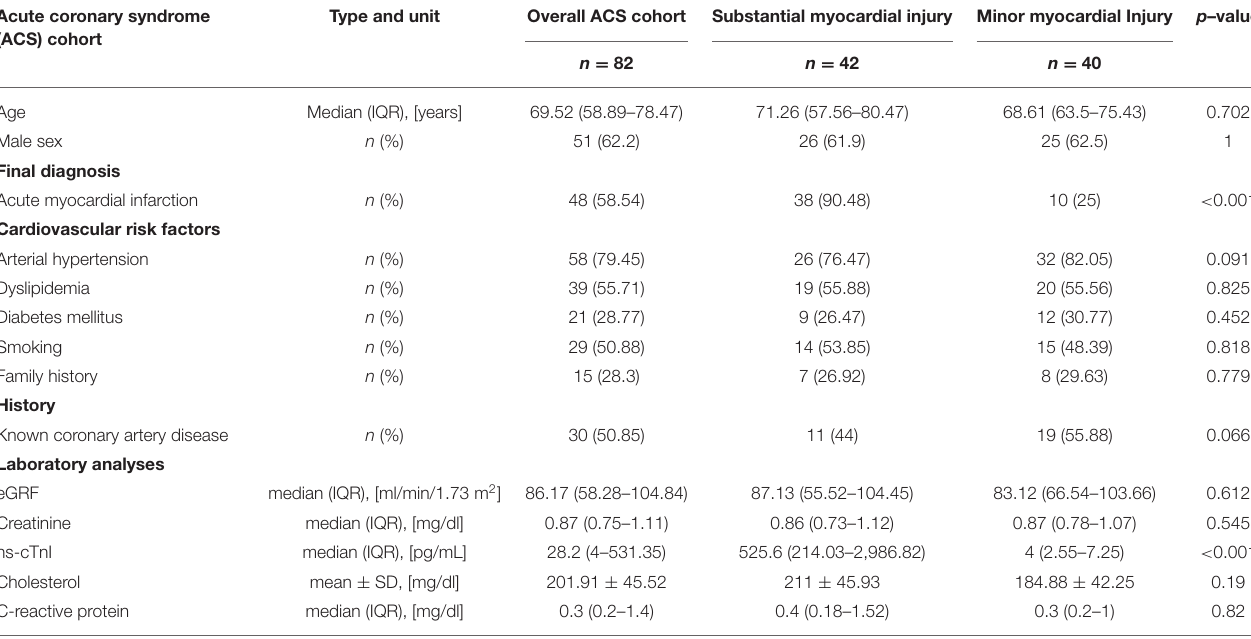
TABLE 1 | Baseline characteristics of the acute coronary syndrome (ACS) cohort. Acute coronary syndrome (ACS)